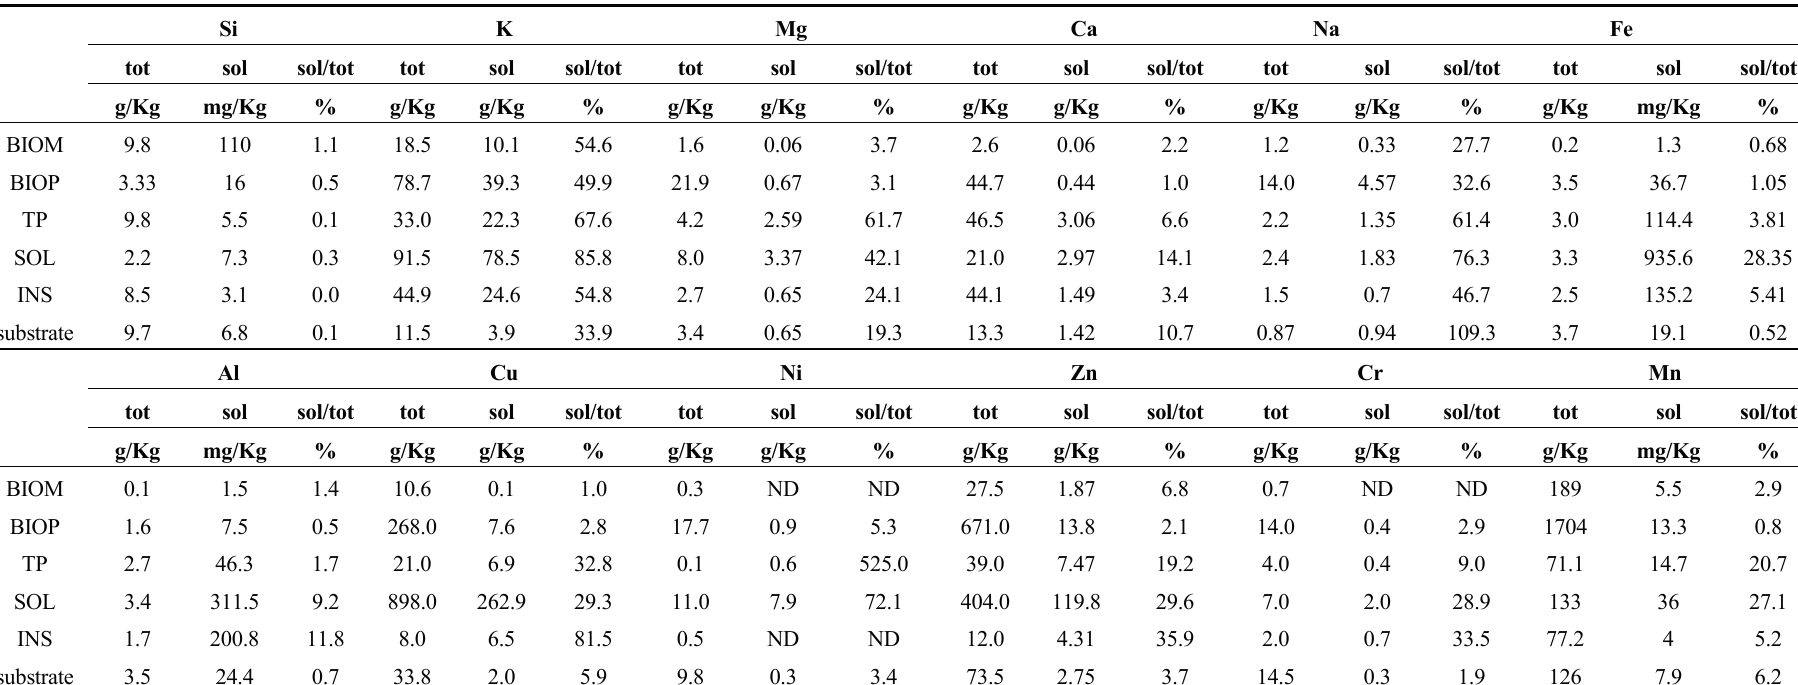
Table 3. Total (tot) and soluble (sol) mineral elements concentration and sol/tot percentage relative to the pot substrate and the pristine added products. Si K Mg tot